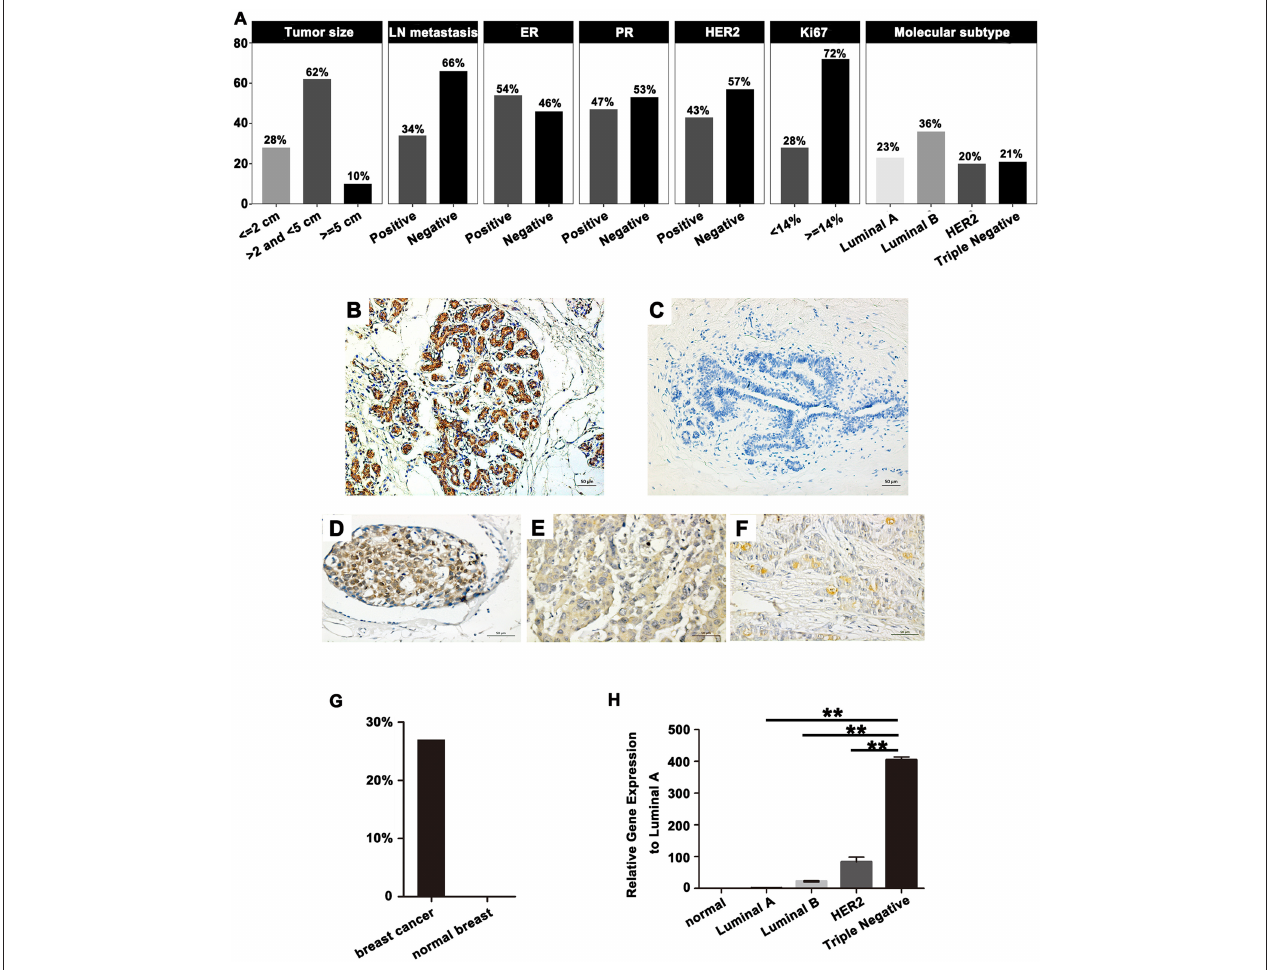
FIGURE 2 | (A) Basic clinicopathological features in 100 breast cancer patients. SPA17 protein expression in (B) normal human testes, (C) normal breast tissue, and (D) low frequency (x ≤ 25%); (E) moderate frequency (25% < x ≤ 75%); (F) high frequency (75% < x ≤ 100%) breast cancer specimens. Human testis was the positive control. (G) SPA17 protein expression rate in breast cancer and normal breast tissue. (H) SPA17 mRNA expression in breast cancer tissues and normal breast tissues. * p < 0.05, ** p <